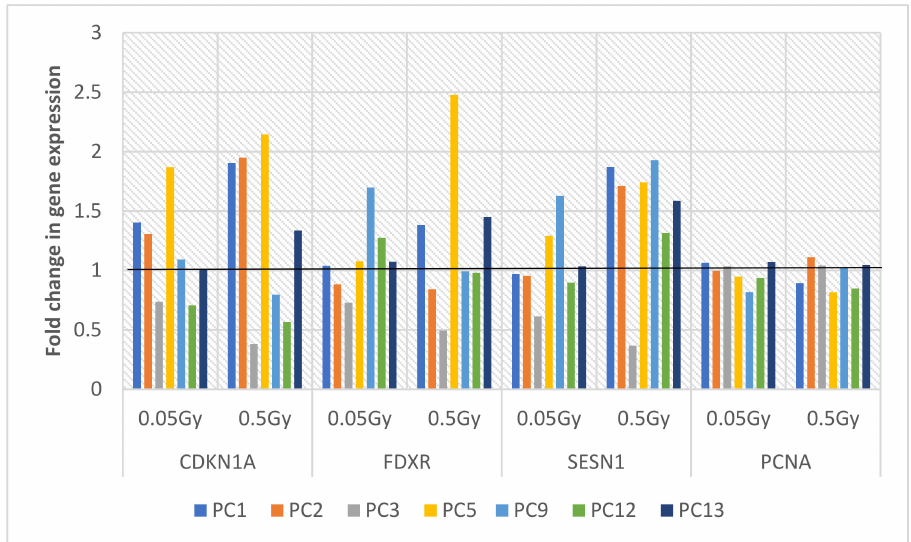
Figure 4. MQRT-PCR of 4 target genes CDKN1A, FDXR, SESN1 and PCNA for 5 baseline prostate cancer donor samples exposed to 0.05 Gy and 0.5 Gy. The fold change threshold is displayed at 1 with a black line traversing each